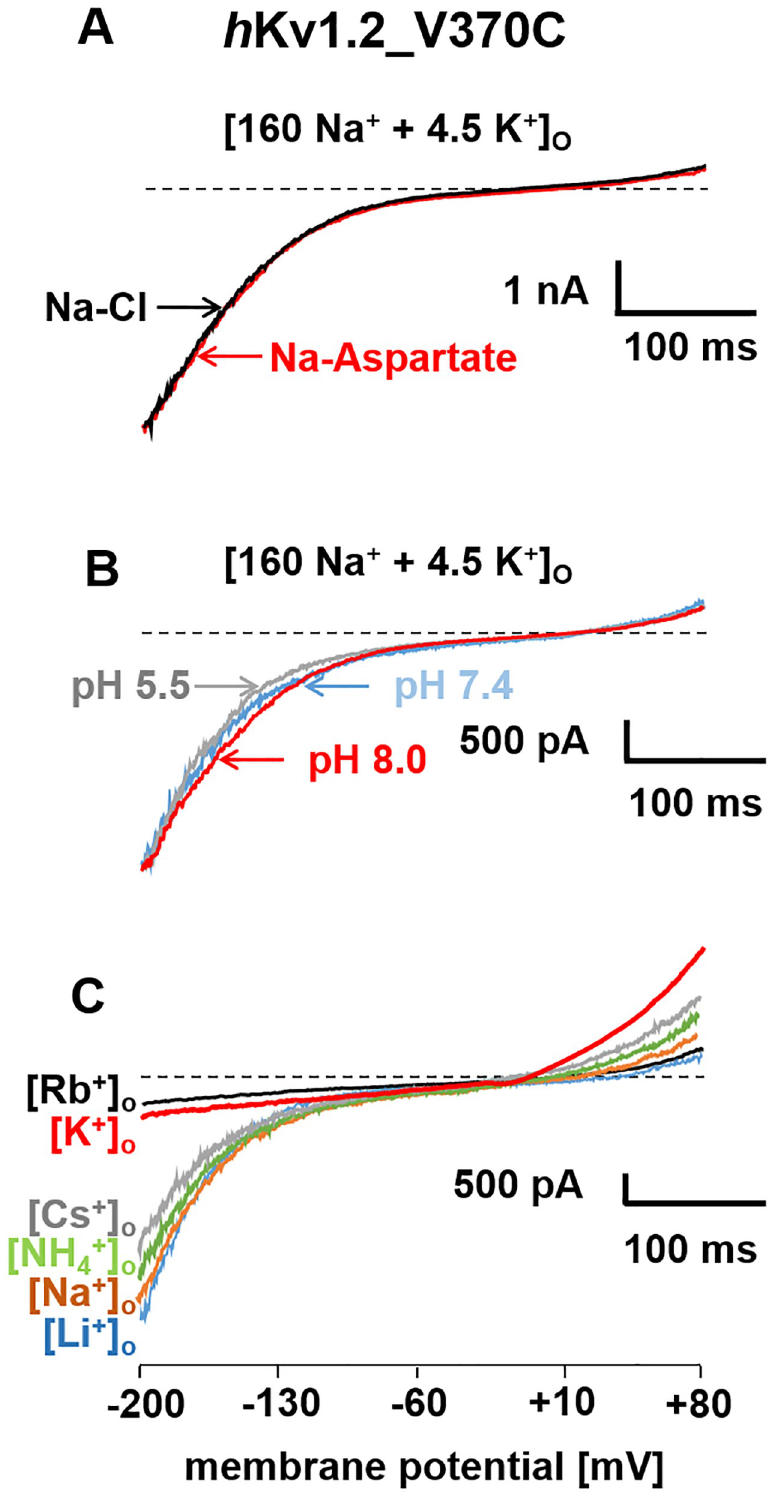
Fig 4. Ion conduction in the h Kv1.2_V370C mutant channel. Ramp currents through h Kv1.2_V370C mutant channels were elicitedas describedin the legendto Fig 1 in different external bathingsolutions.The main anions ( A ) and cations ( C ) in the bathingsolutionor the pH of the external bathingsolution( B ) are shown at each current trace.